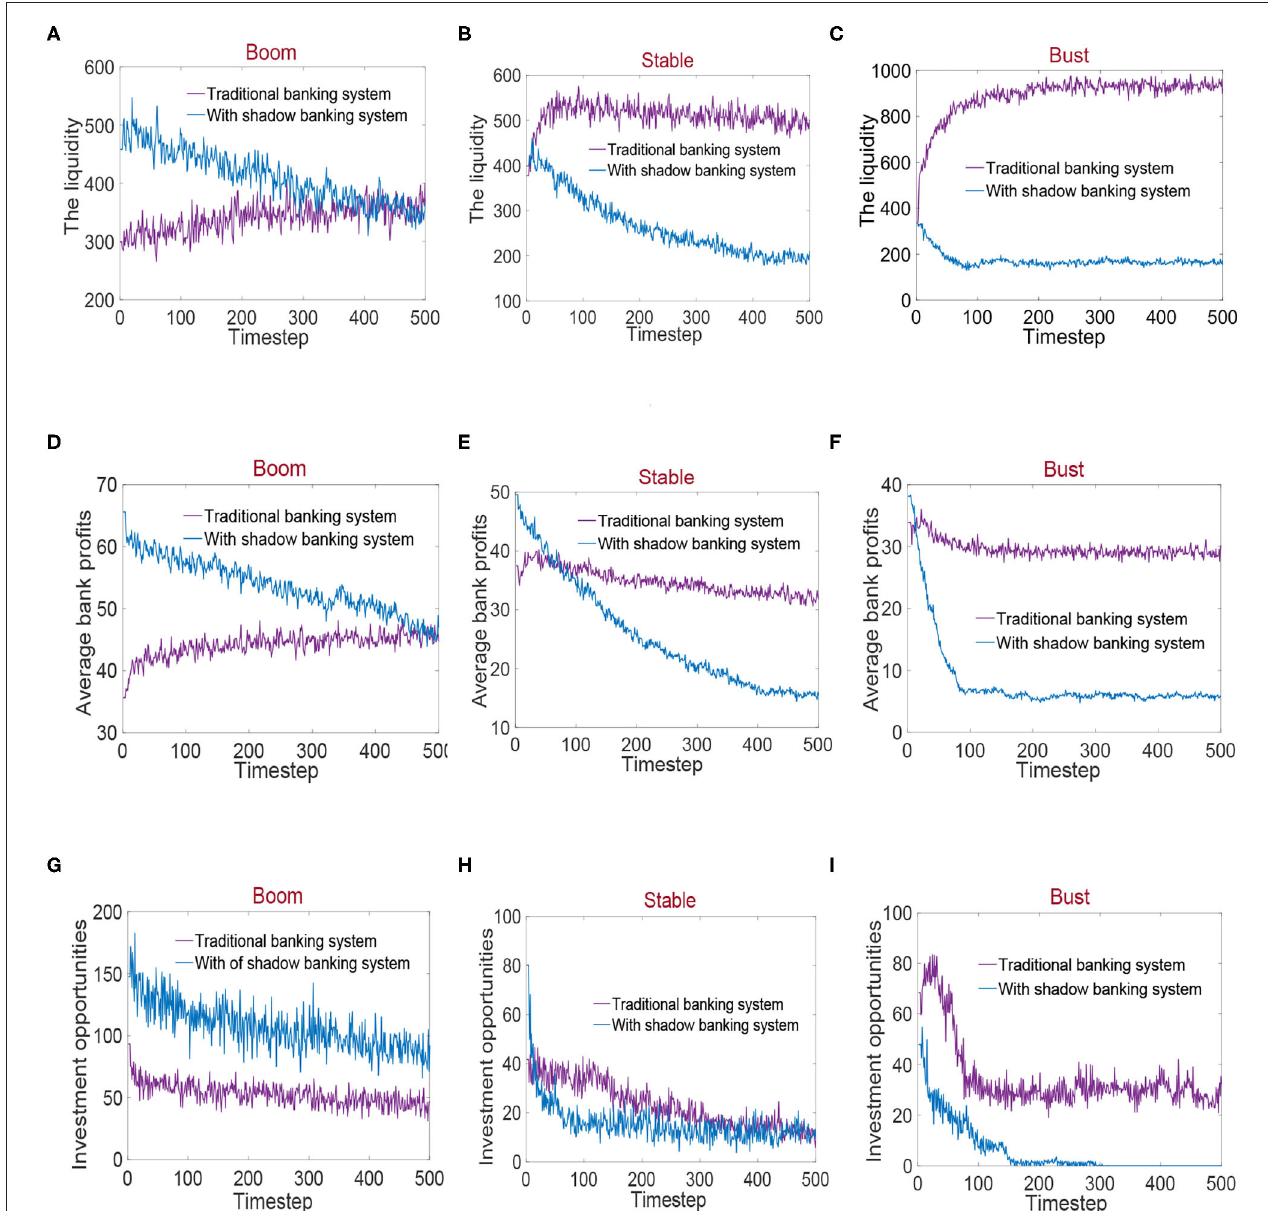
FIGURE 2 | (A–C) Representation of the changes in liquidity in the banking systems under macroeconomic fluctuation. (D–F) Representation of the changes in average bank profits in the banking systems under macroeconomic fluctuation. (G–I) Representation of the changes in investment opportunities in the banking systems under macroeconomic